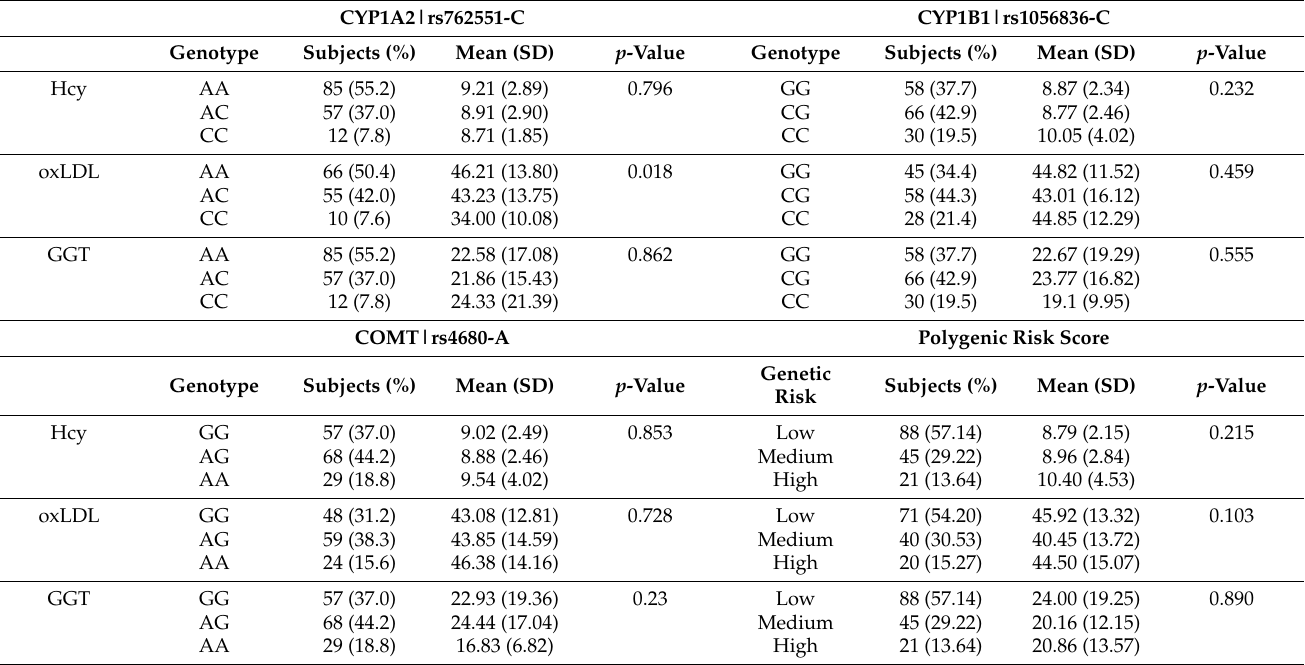
Table 4. Association between genetic variants in Phase I/Phase II detox enzymes and levels of homocysteine, oxLDL, and GGT. For each biomarker (rows), we report the mean levels and standard deviation in groups of subjects carrying the same genotype of the selected genetic